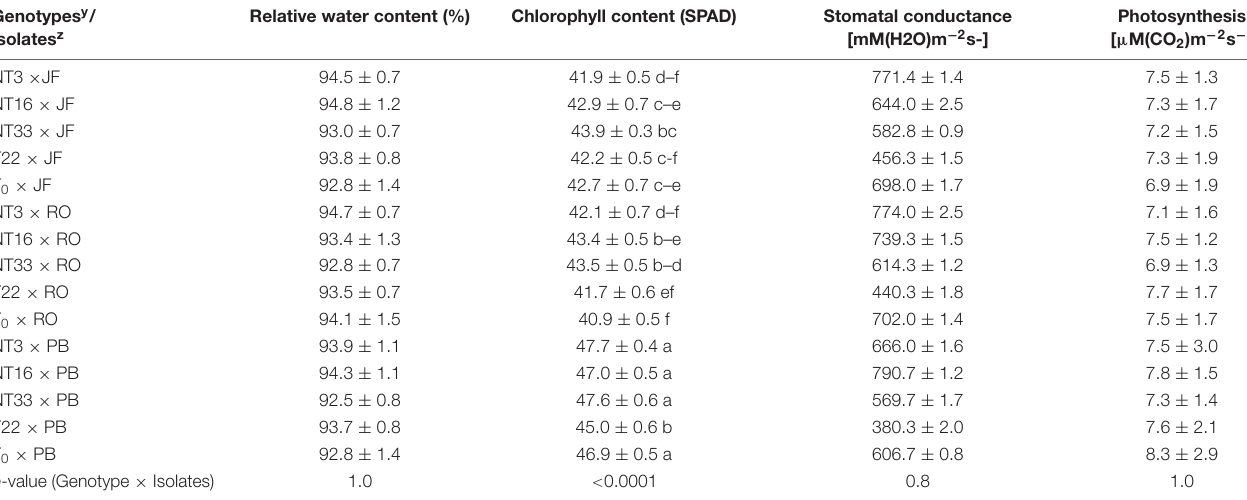
Genotypes y / Isolates